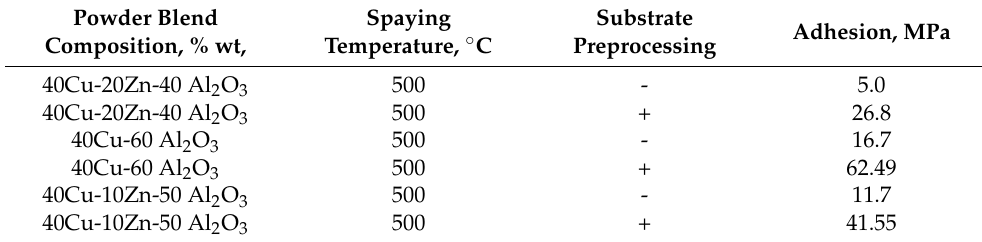
Figure 3. General view of the system simulating a contact wire after the restoration of segments 1, 3, 5, 7. Table 2. The measured adhesion values of cold sprayed layers.